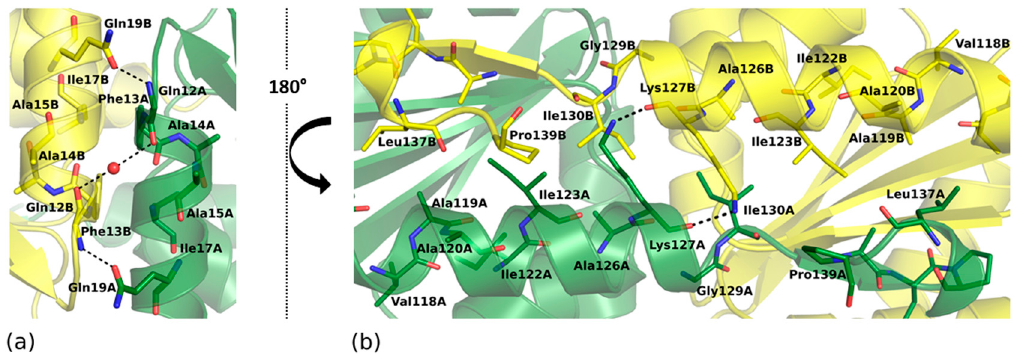
Figure 4. Dimeric interface of SpEIIA-Man. Secondary structure elements of protomers are represented in yellow and green. Carbon atoms are colored according to their polypeptide chain, nitrogen in blue, oxygen in red, and water molecules are depicted as red spheres ( a ) Amino acids involved in the α 1– α 1 ′ interface (S1 subsite) and ( b ) Amino acids involved α 5– β 5 ′ and α 5 ′ – β 5 interfaces (S2 subsite).